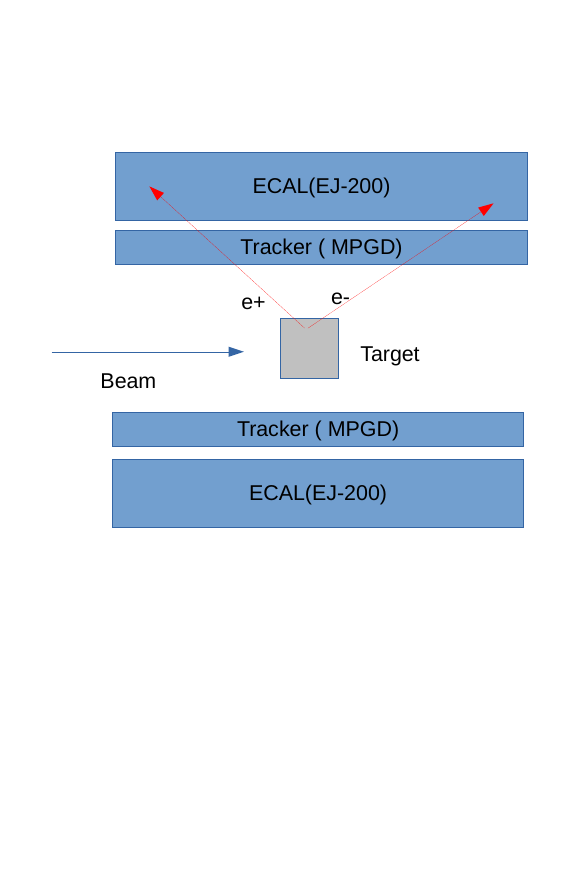
Figure 2. Conceptual design of the 3 He(n,e-e + ) 4 He at EAR2. The neutron beam strikes on a 3 He target, done in special carbon fiber, 0.6 mm thick, 300 - 350 atm. The tracks direction are measured for the first 3 cm with the inner detector (TPC) then by the EJ-200 slab planes, the energy of each particle is measured with an e.m. calorimeter with adequate granularity